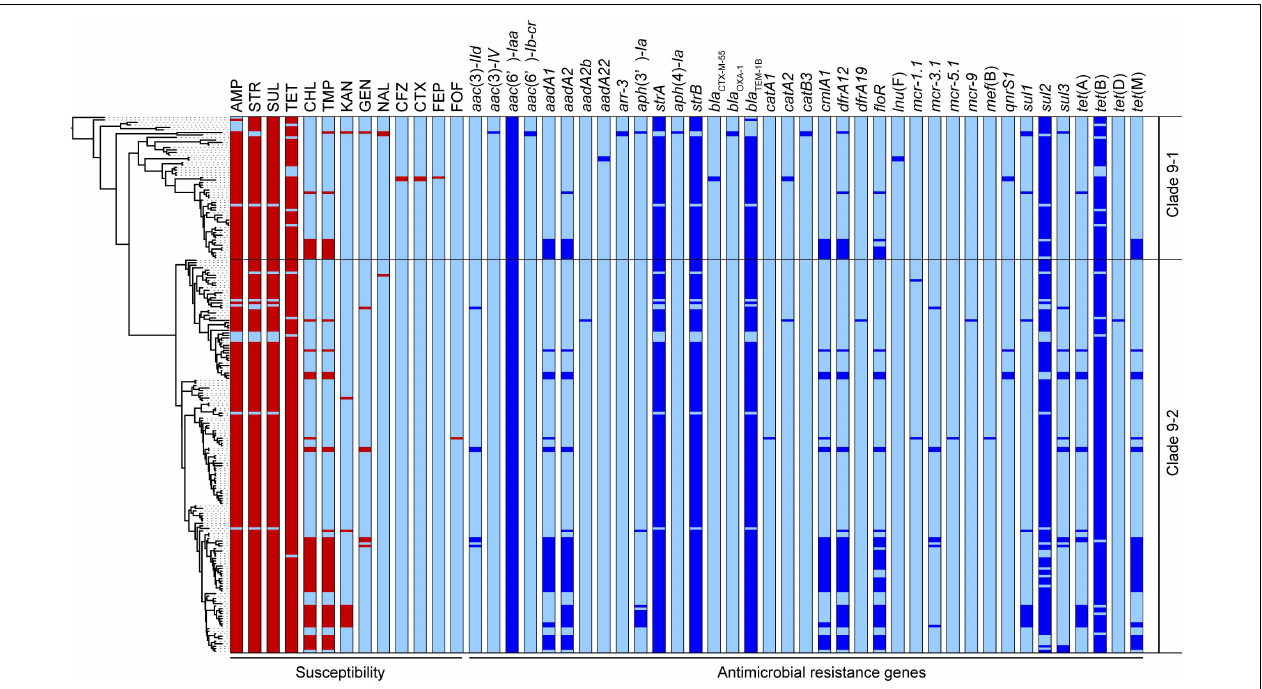
FIGURE 3 | The antimicrobial susceptibilities and distributions of AMR genes are shown beside the phylogenetic tree represented in Figure 1 . The red and light blue colors related to susceptibility (left side) indicate the resistance and susceptibility to each antimicrobial, respectively. The abbreviations are as follows: AMP, ampicillin; STR, streptomycin; SUL, sulfonamides; TET, tetracycline; CHL, chloramphenicol; TMP, trimethoprim; KAN, kanamycin; GEN, gentamicin; NAL, nalidixic acid; CFZ, cefazolin; CTX, cefotaxime; FEP, cefepime; FOF, fosfomycin. The blue and light blue colors related to the AMR genes (right side) indicate the presence and absence of each gene,